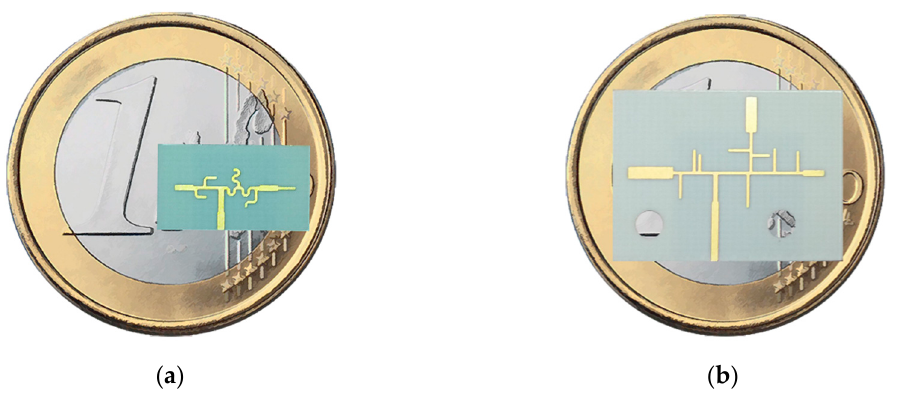
Figure 6. Prototypes Built: ( a ) Dual-Band and ( b ) Tri-Band Antennas.